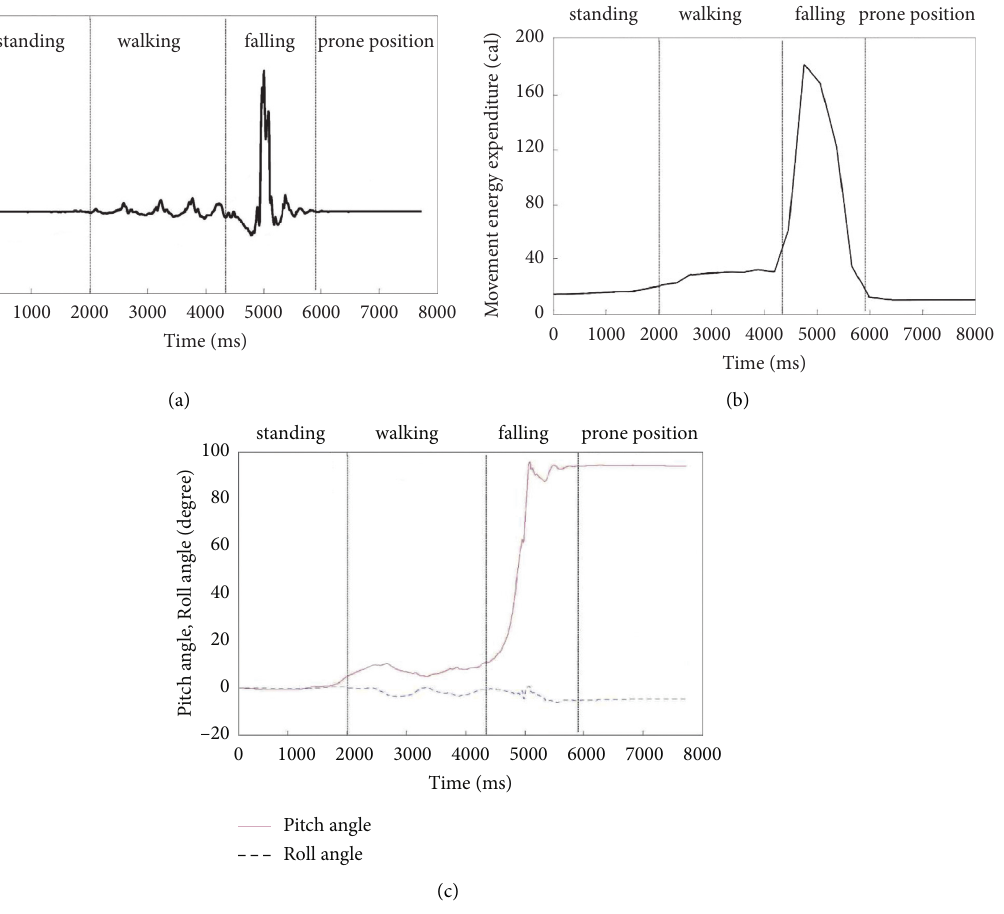
Figure 3: Example of calculation results of combined acceleration, movement energy expenditure, pitch angle, and roll angle in Algorithm 1. (a) Example of combined acceleration. (b) Example of movement energy expenditure. (c) Example of pitch angle and roll